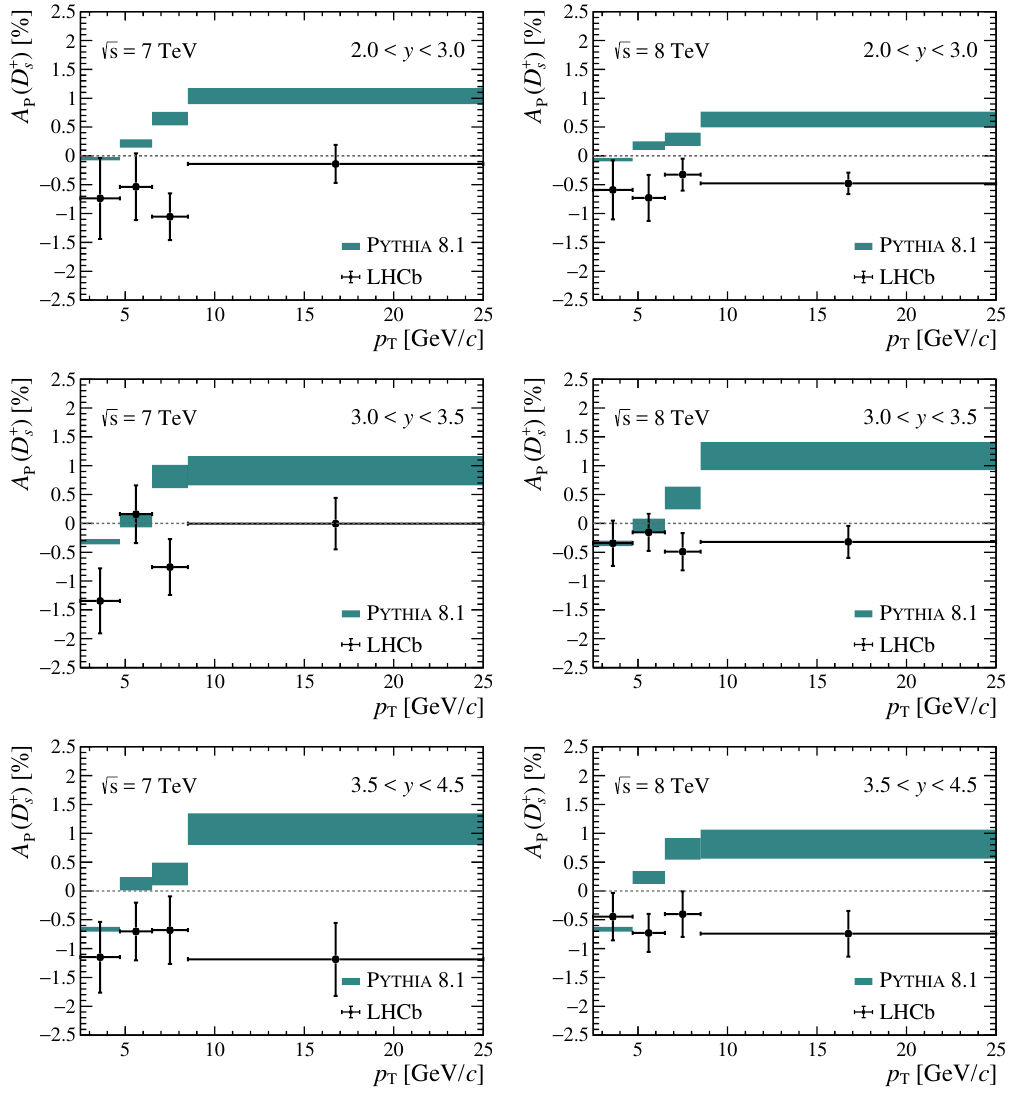
production asymmetry as a function of p T s p s = 7 TeV and (right) 8 TeV data sets, compared